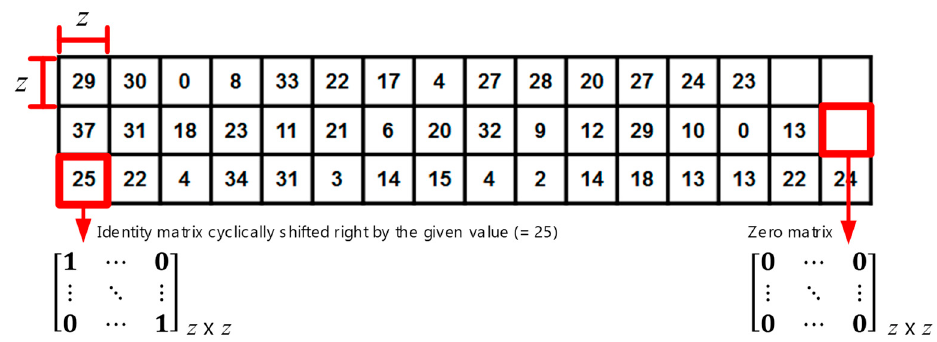
Figure 2. Example of QC-LDPC matrix.